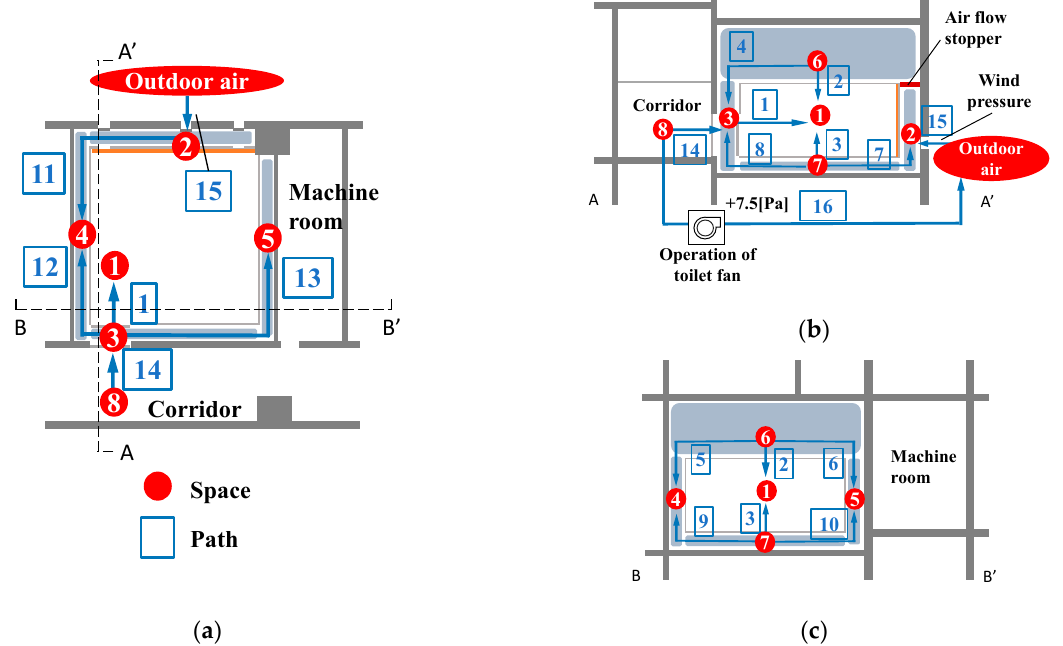
Figure 7. Ventilation network of the storage room: ( a ) horizontal section; ( b ) cross section A–A’; ( c ) cross section B–B’.